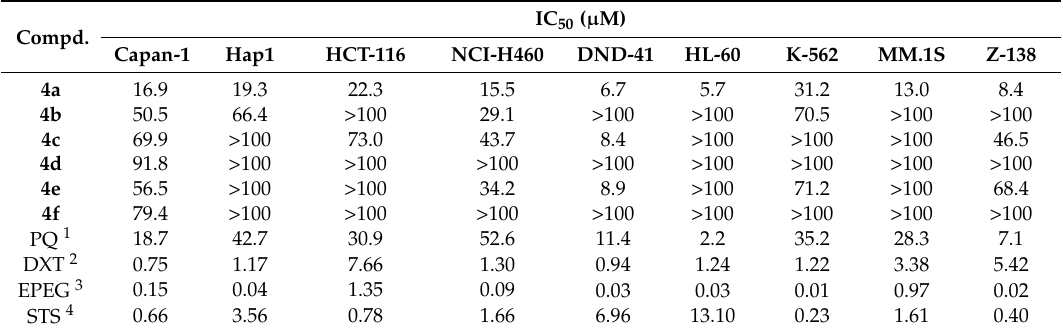
Table 4. Antiproliferative screening of fumardiamides 4a – f in diverse human tumor cell lines.